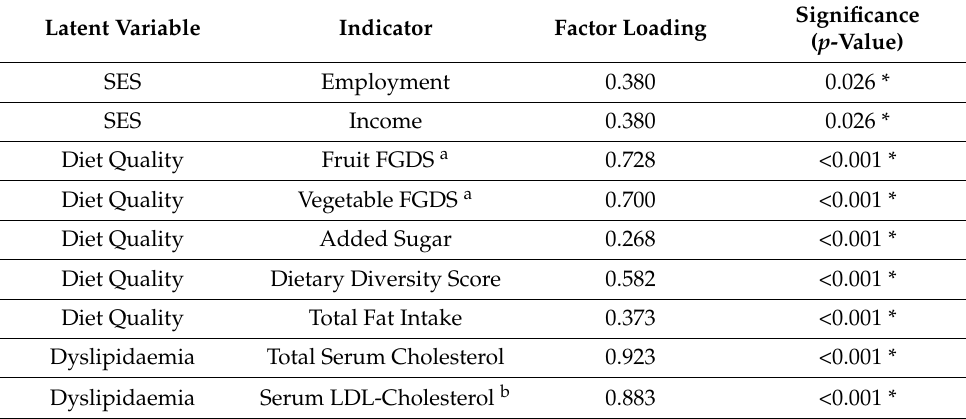
Table 2. Relationship between latent variables and their